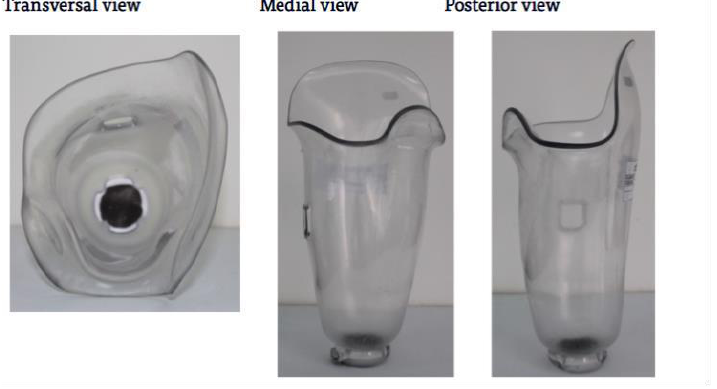
Figure 8. Socket